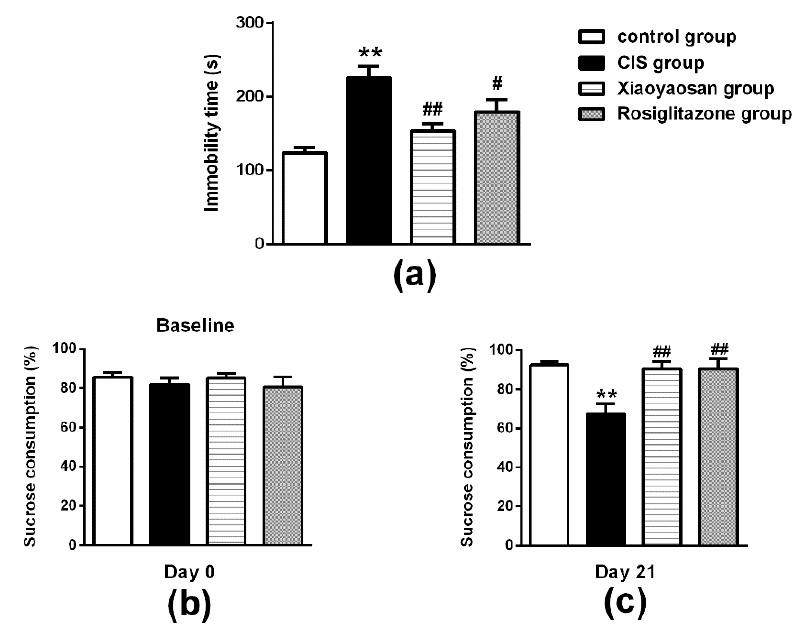
Figure 3. Effects of Xiaoyaosan on stress-induced depression-like behaviour. ( a ) Immobility time within 5 min in the FST. ( b ) Sucrose consumption rate in the SPT before CIS. ( c ) Sucrose consumption rate in the SPT after 21 days of CIS. Data are presented as the means ± SEM with 9–10 rats in each group. ** p < 0.01 versus the control group. # p < 0.05 or ## p < 0.01 versus the CIS group.